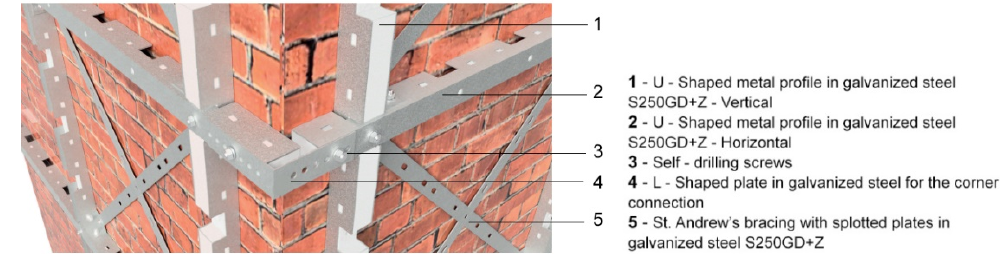
Figure 4. Connection of the CFS walls in the building corner.